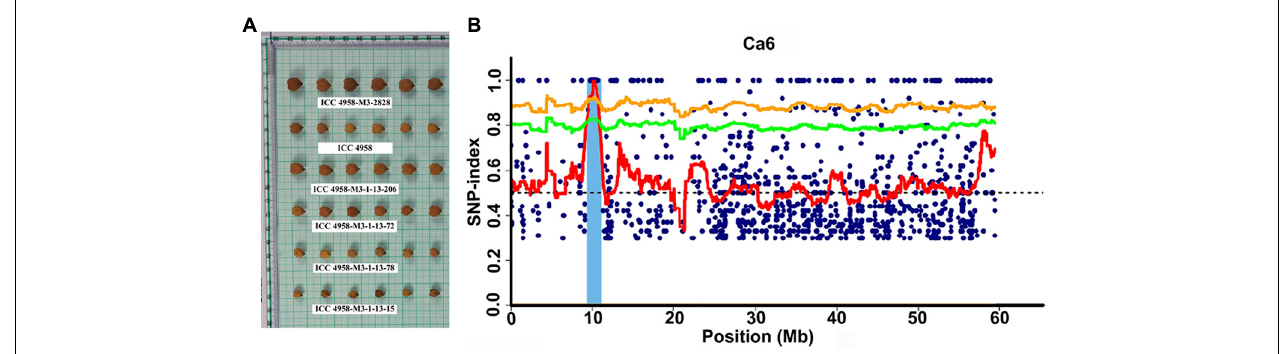
FIGURE 2 | Phenotypic variation for seed size and identification of candidate genomic region using MutMap approach. (A) Representative picture showing the variation in seed size in the MutMap population developed crossing ICC 4958-M3-2828 × ICC 4958 (wild). (B) A genomic region on Ca6 x-axis indicates the physical position of the chromosome, and the y-axis indicates the average SNP-index in a 2 Mb interval with a 10 kb sliding window.